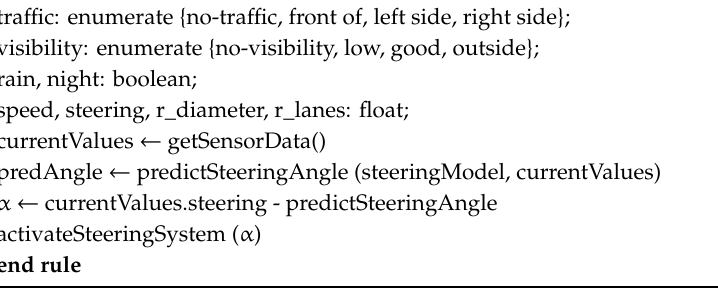
Algorithm 2. Rule for Steering Angle Adjustment .